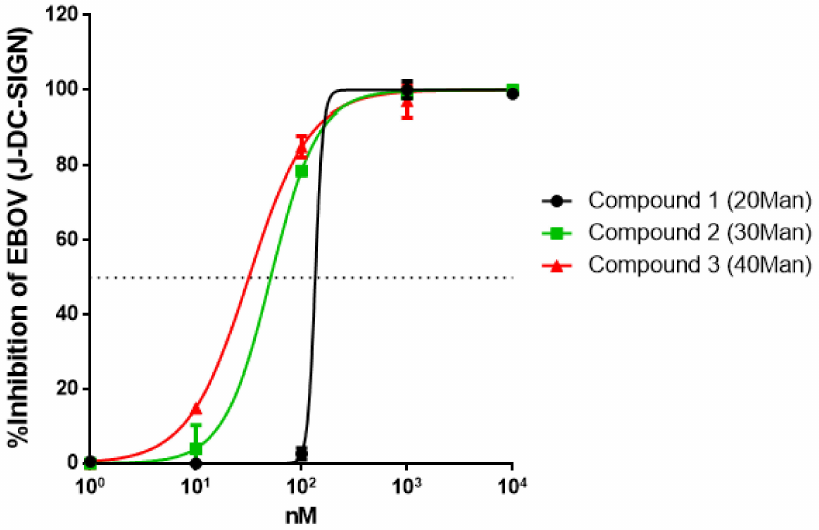
Figure 3. Effects of compounds 1 (20 Man), 2 (30 Man), and 3 (40 Man) on Ebola pseudotype virus infection on Jurkat DC-SIGN. Jurkat DC-SIGN cells were cultured in media containing increasing concentrations of compounds 1 , 2 , or 3 (0–10 4 nM) for 30 min. before infection with EBOV pseu- dotyped viral particles. After 48 h, virus infection was measured and illustrated as percentage of inhibition with respect of the control. Values on the graph correspond to the mean of 3 independent experiments with error bars corresponding to the standard errors of the mean. The IC 50 values were estimated using GraphPad Prism v6.0 with a 95% confidence interval and settings for normalized dose–response